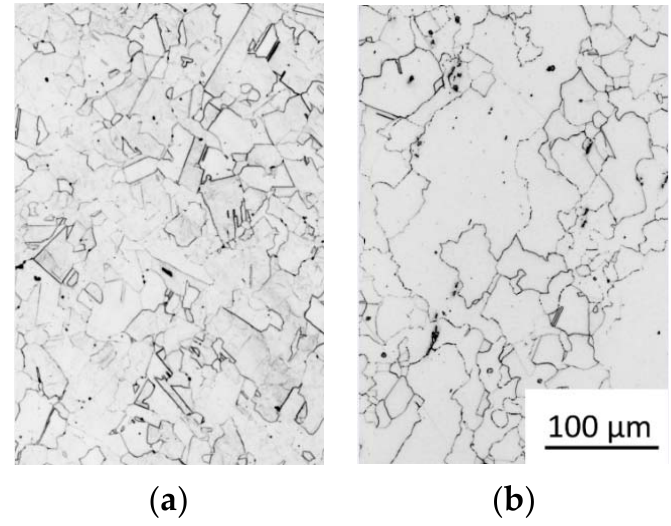
Figure 16. Post ‐ deformation microstructure: φ = 2.5 ( a ) MoNiCr; ( b ) HN80MTY. Figure 16. Post-deformation microstructure: φ = 2.5 ( a ) MoNiCr; ( b )